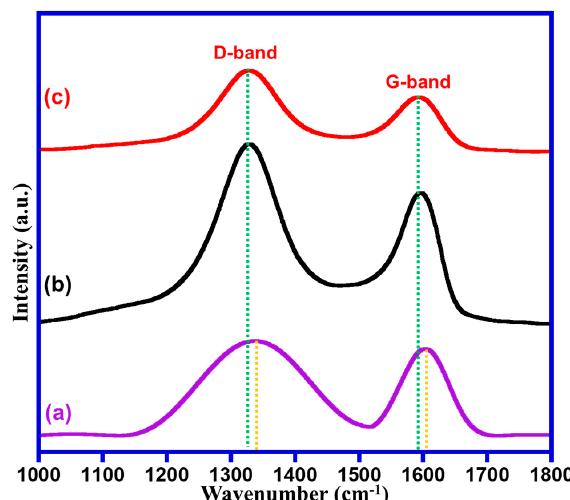
Figure 6. Raman spectra of ( a ) GRO, ( b ) NDG and ( c ) (1%)NDG / MnCO 3 –(1%)ZrO 2 samples.